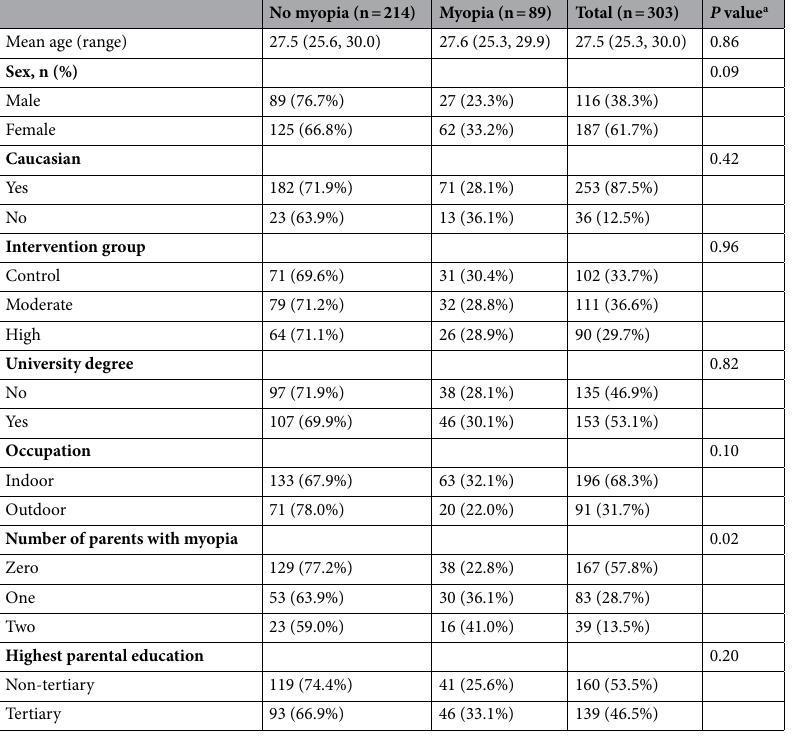
Table 2. Demographics of participants of the Kidskin Young Adult Myopia Study. 14 individuals were missing all questionnaire data. a t test or chi square test where